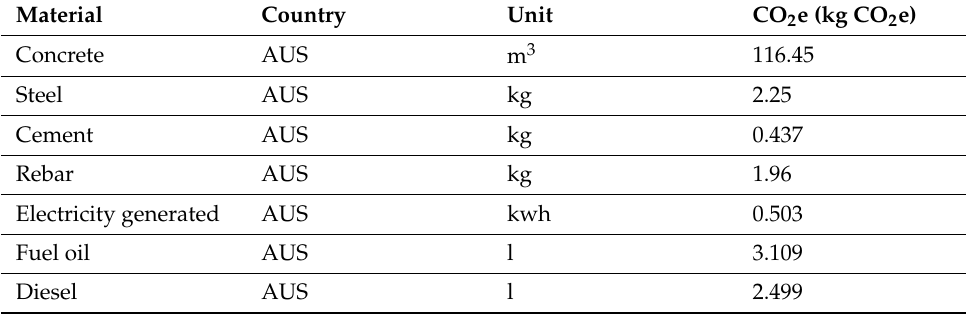
Table 2. GHG Emission factors (f) per one unit of material or by energy type [50].